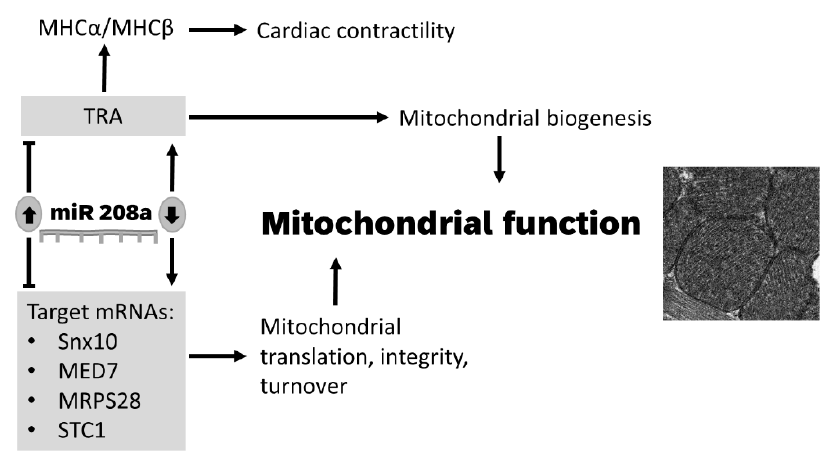
Figure 6. Model for the role of miR 208a in regulating mitochondrial function in cardiomyocytes . A decrease in miR 208a expression activates mitochondrial biogenesis via thyroid signaling and derepresses factors that control nuclear transcription, mitochondrial translation, oxidative stress, integrity, and turnover. SNX10, Sortin nexin 10; MED7, mediator complex subunit 7; MRPS28, mitochondrial ribosomal protein S28; STC1, Stanniocalcin 1; TRA, thyroid hormone receptor A; MHC α , myosin heavy chain α ; MHC β , myosin heavy chain β .